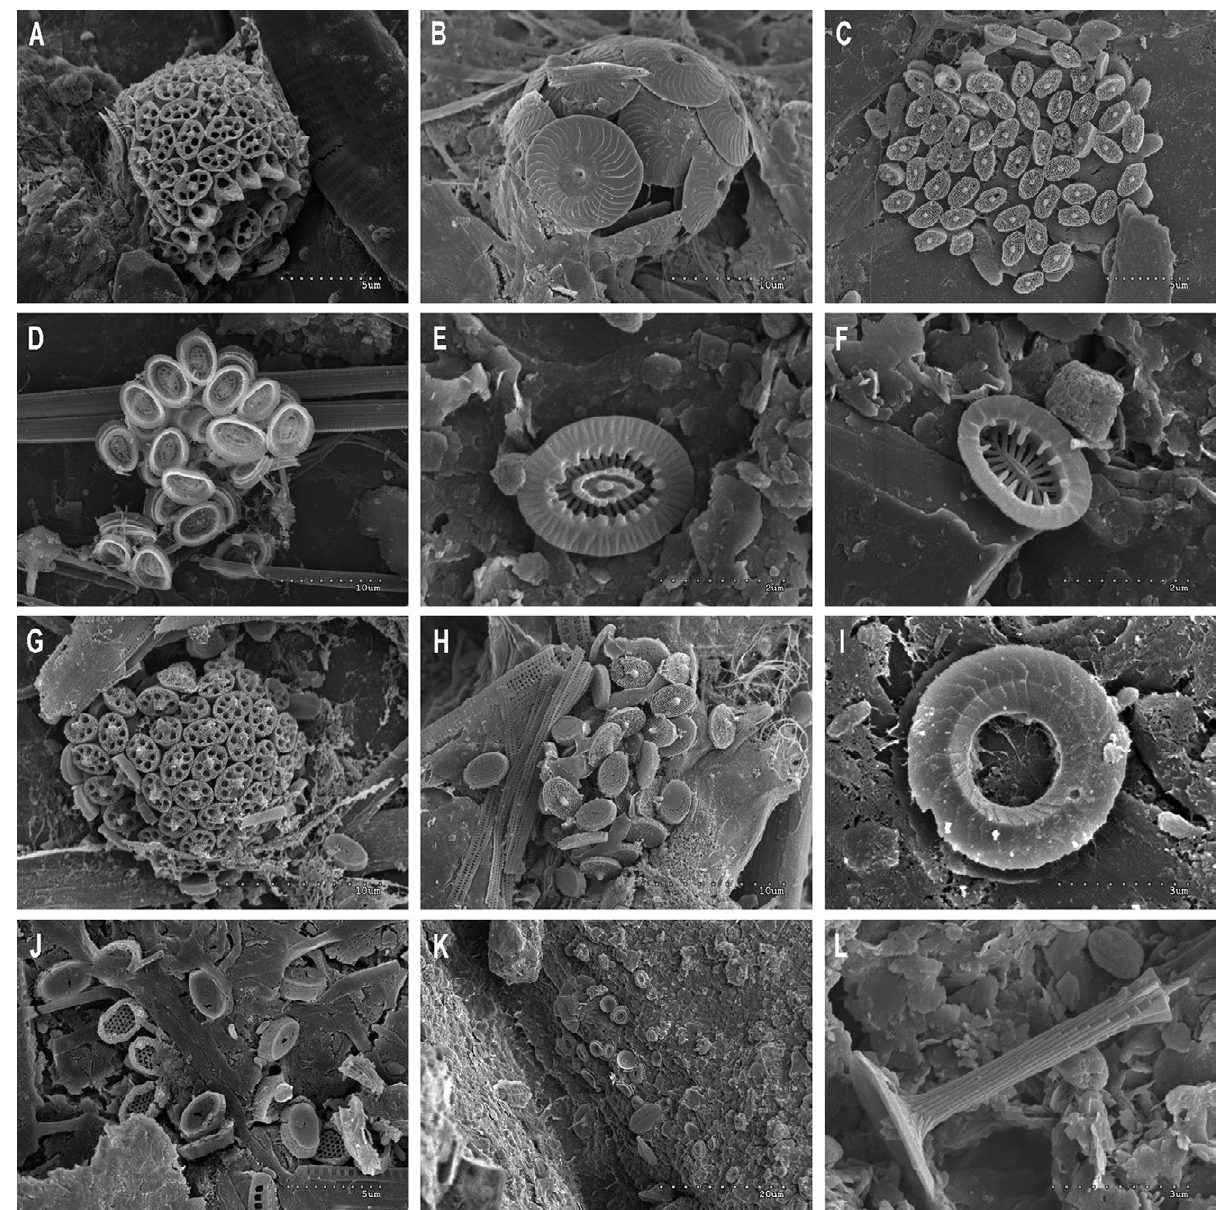
Fig. 4. – Coccolithophores. A, Coronosphaera mediterranea HOL (formerly “ Calyptrolithina wettsteinii ”); B, Calcidiscus leptoporus ; C, Zy- gosphaera hellenica ; D, Syracosphaera pulchra ; E, Syracosphaera molischii ; F, Syracosphaera halldalii ; G, Helicosphaera carteri HOL (for. “ Syracolithus confusus ”); H, Helicosphaera carteri HOL (for. “ Syracolithus catilliferus ”); I, Umbilicosphaera sibogae ; J, Holococcosphaera dentate (for. “ Calyptrosphaera ”); K, Coccoliths of Emiliania huxleyi on sediment; L, Rhabdosphaera clavigera